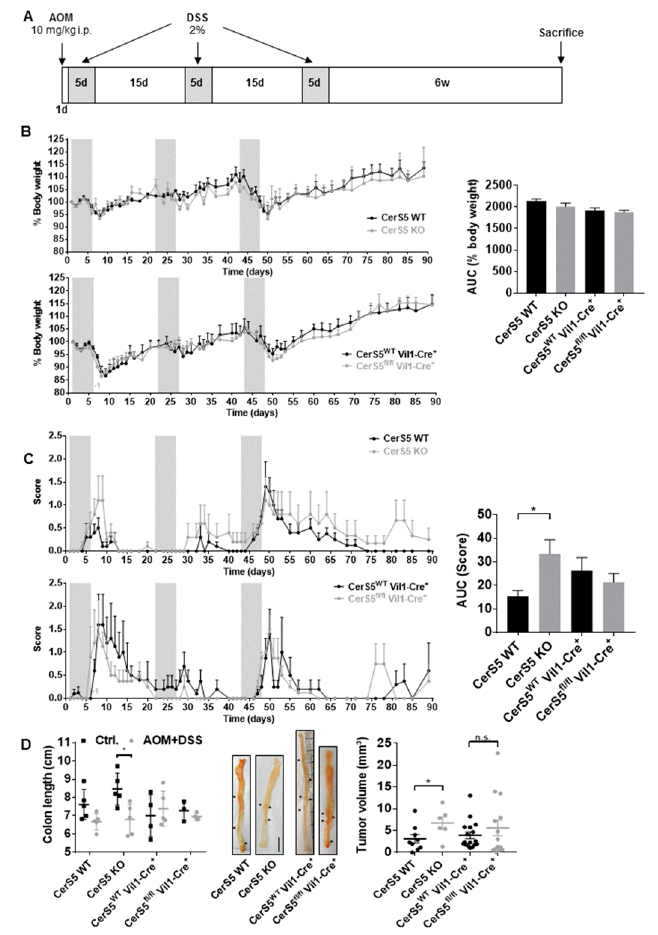
Figure 2. In CerS5 ‐ wt and CerS5 ‐ ko as well as in CerS5 ‐ wt ‐ VilCre and CerS5fl/fl VilCre mice, the clinical course and pathology of AOM/DSS ‐ induced colitis ‐ associated colon cancer were investigated. ( A ) Treatment schemata: at day 1, 10 mg/kg AOM were injected intraperitoneally (i.p.), followed by application of three cycles of 2% DSS in the drinking water for 5 days and 15 days recovery. Body weight ( B ) and disease score ( C ) were followed up for 90 days. The area under the curve (AUC) was calculated for each treatment group and compared by Student’s t ‐ test; p * = 0.05. At the end, mice were sacrificed and colon length and tumor development were investigated ( D ). Data are mean ± SEM. Statistical analysis was performed by one ‐ way ANOVA. Mice n = 5 for each group.